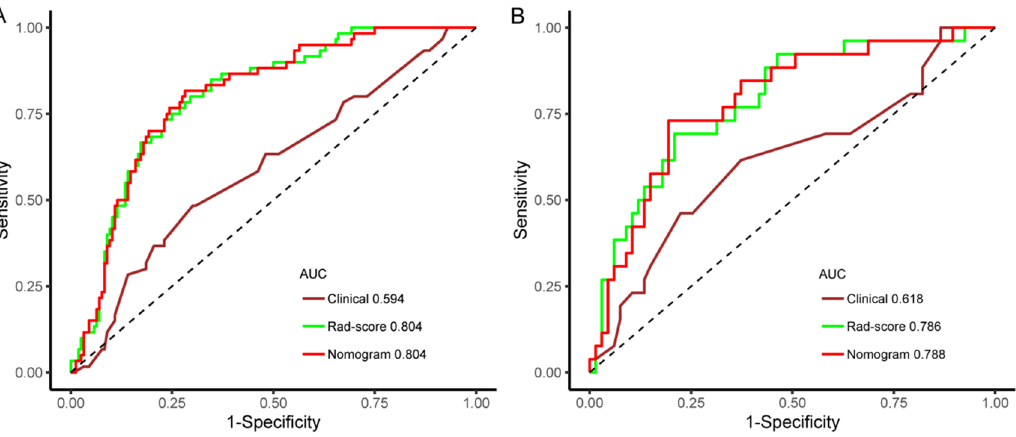
Figure 9. Receiver operating characteristic curves of the three models predicting HER2+ type in the training ( A ) and validation sets ( B ). training ( A ) and validation sets ( B